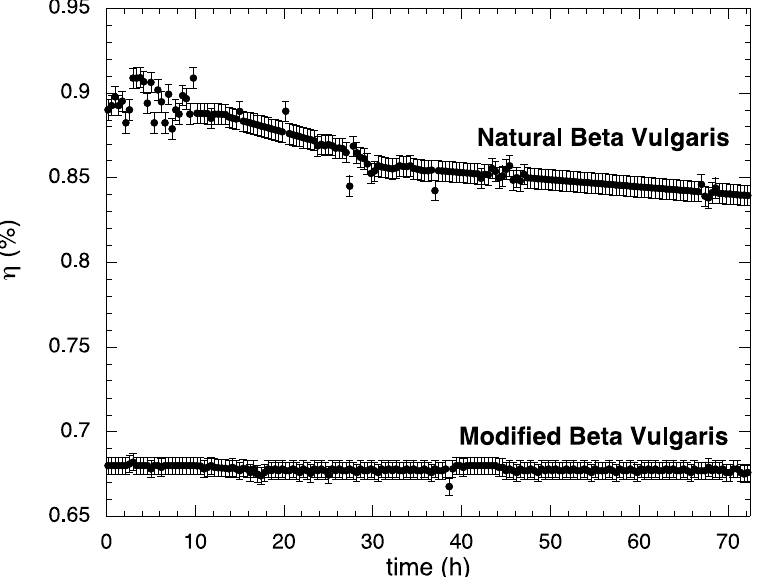
Figure 6. Time dependence of the efficiency for BVE and BVE/TEOS solar